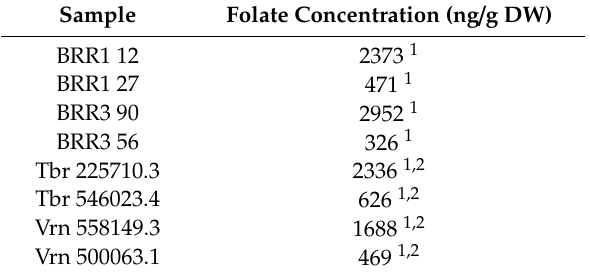
Table 3. Folate concentrations of samples used in real time quantitative RT-PCR